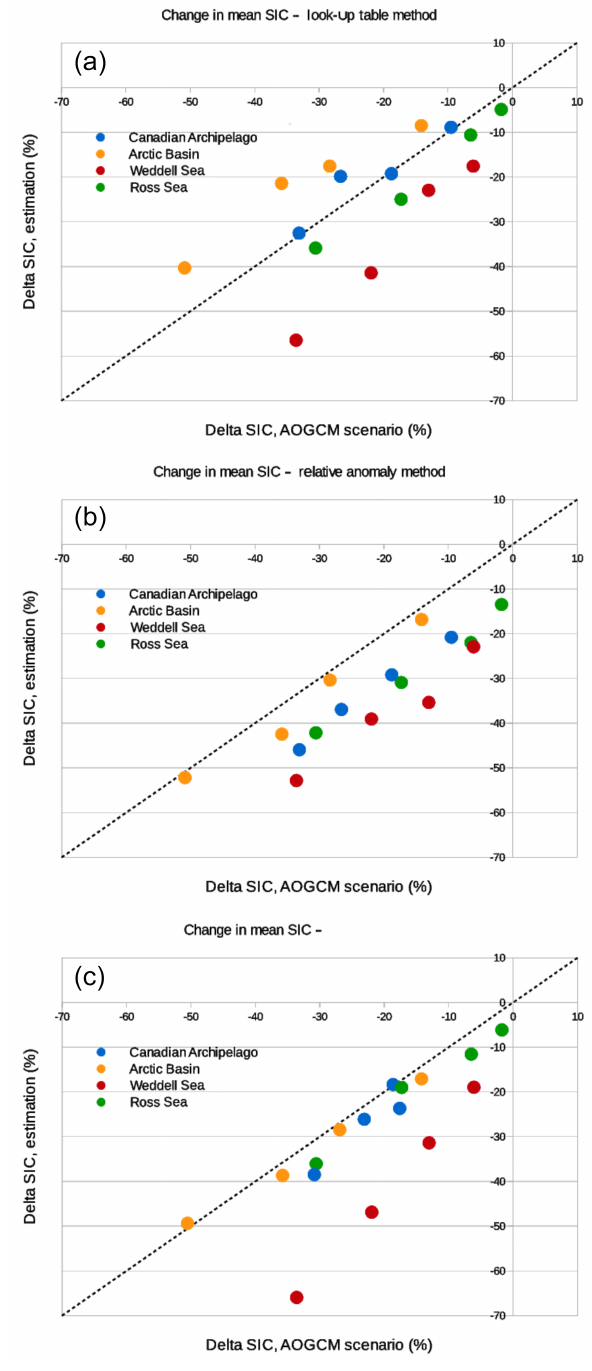
Figure 7. Change in mean bias-corrected SIC projections using (a) look-up table, (b) iterative relative anomaly and (c) analogue methods against corresponding mean change in the A OGCM pro- jection for the four test regions: Canadian Archipelago (blue), Arc- tic Basin (orange), Weddell Sea (red) and Ross Sea (green) for pro- jections from CNRM-CM5 and IPSL-CM5A-LR.